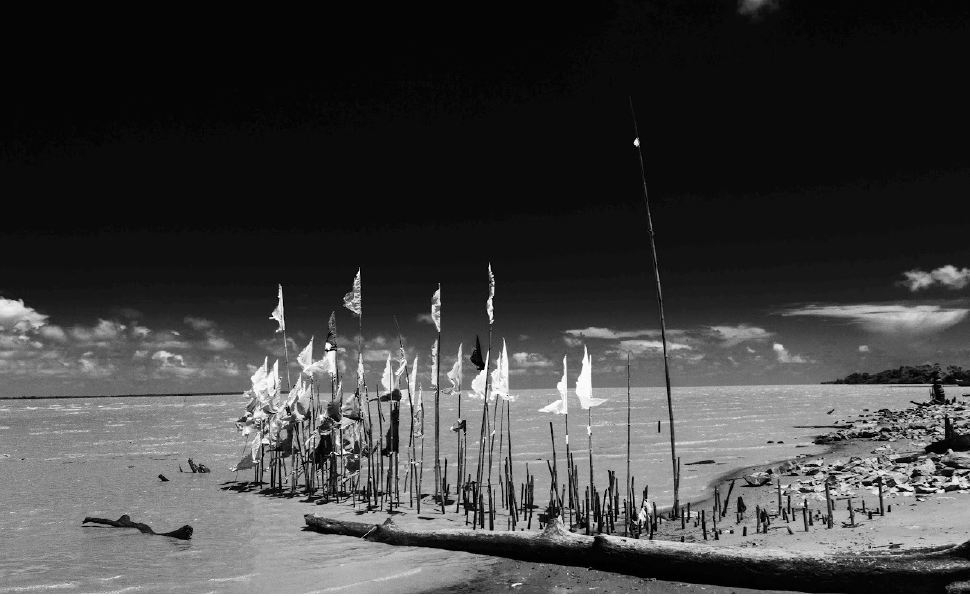
Figure 4. Michael Lam, Devotion Poin t (Bushy Park, Parika, Essequibo), from the series, Oniabo ,